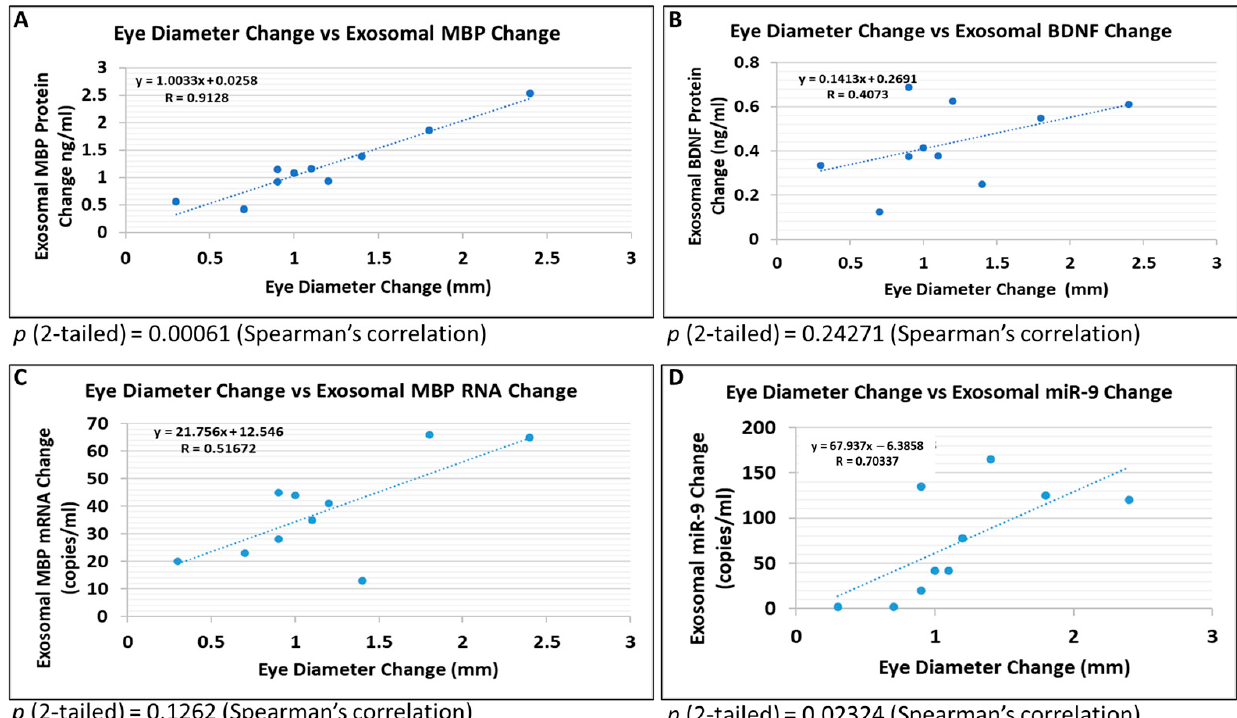
Figure 6. Correlations between human fetal eye size and fetal brain-derived exosomal molecular markers. Eye diameters were measured in histological sections from EtOH-exposed samples and unexposed controls. Protein levels were measured by ELISA (for MBP and BDNF). RNA copy numbers were measured by ddPCR (miR-9 and MBP). Ten EtOH-exposed fetal eye tissues each were paired with an age- and sex-matched control, and with their matching maternal blood samples from 1st and 2nd trimester pregnancies. Assays were performed in triplicate on contents of FB-Es isolated from the maternal blood. Each dot represents the ratio of the values for each fetus vs. its matched control. ( A ) Correlation between change in eye size (difference between EtOH-exposed fetus and its paired control) and changes in exosomal MBP protein levels presented as a scatter plot. ( B ) EtOH-associated changes in exosomal BDNF protein levels ( p = 0.1262, not significant). ( C ) Correlation between eye diameter changes and changes in FB-E miR-9 copy numbers ( p = 0.24271, not significant). ( D ) As in ( C ), but for OL-E MBP mRNA copy numbers. Calculations are based on Spearman’s correlation on exact Two-Tailed Probabilities critical p values for N > 2 ≤ 18, and very accurate critical values for N > 18 < 101, estimated using the Edgeworth approximation [47,48]. Only p -values less than 0.05 ( A , D ) are considered significant.